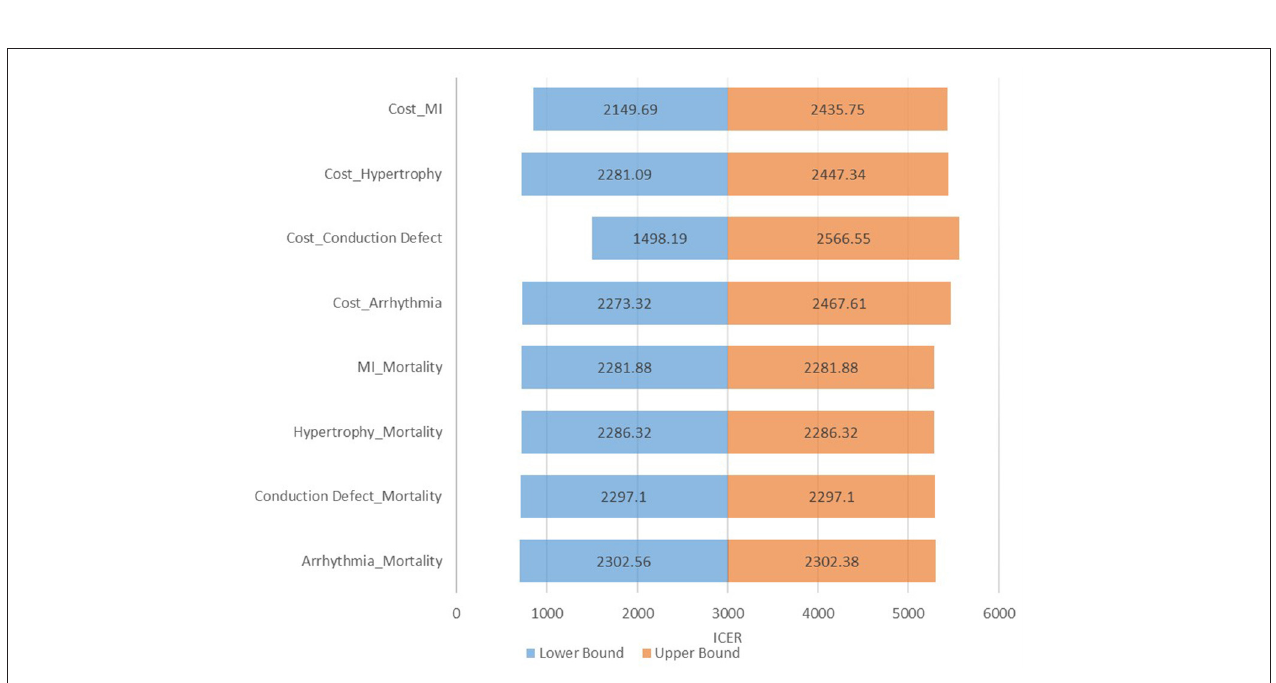
FIGURE 3 | Tornado diagram. The tornado diagram depicts minor variation in ICER after controlling one variable at a time, indicating robustness of the model and its interpretation.